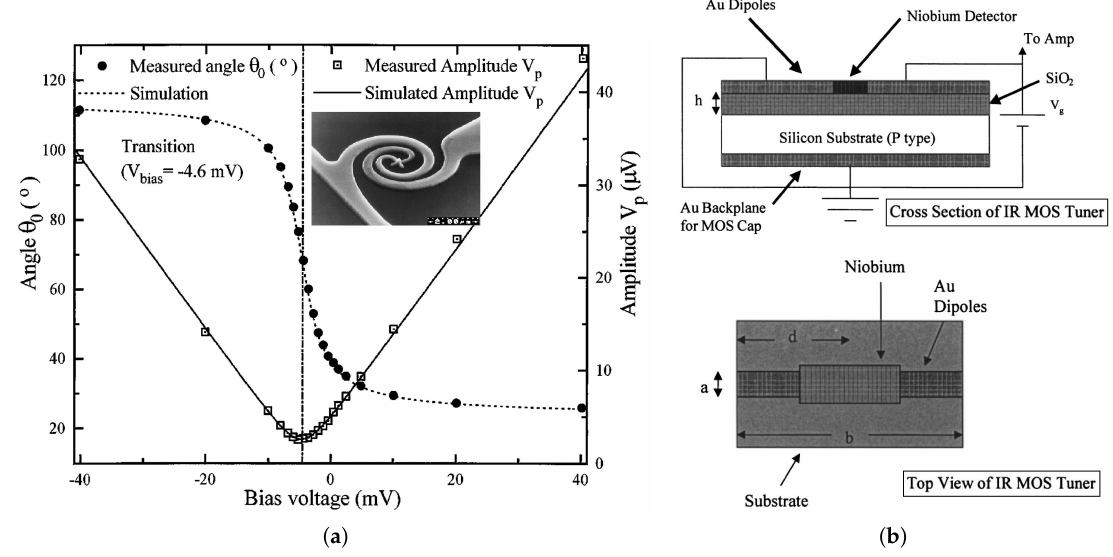
Figure 7. Tunable antenna coupled IR detectors: ( a ) Polarization tunable measured response with different bias voltages [50], ( b ) Illustration of MOS tuner structure [52]